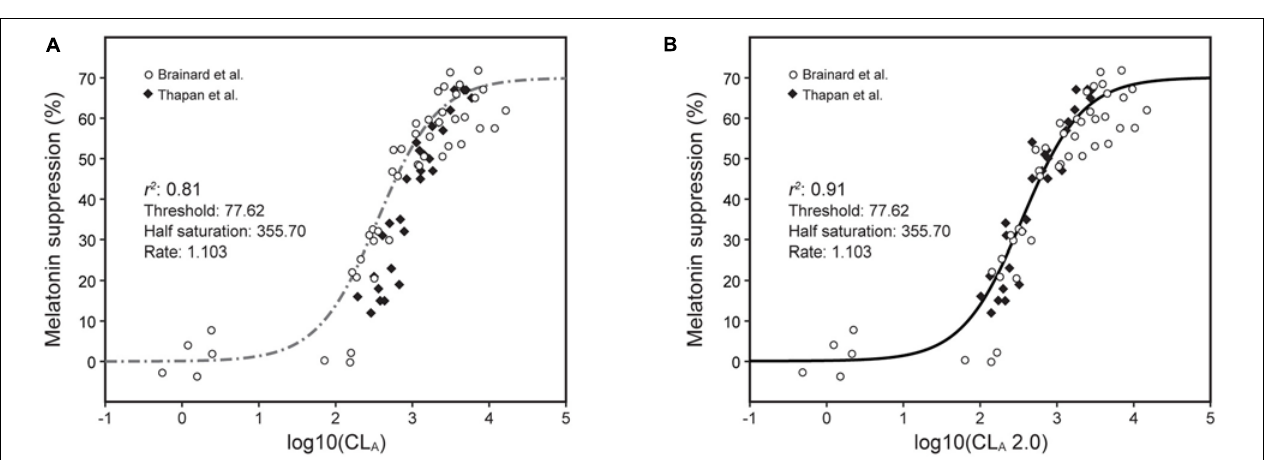
FIGURE 5 | The data in panels (A,B) are for 1-h exposures, plotted as a function of CL A 2.0 from Eq. 3. (A) shows the data separated in terms of three different spatial distributions of the light stimulus: f = 2.0 (green), f = 1.0 (red), and f = 0.5 (blue). (B) shows these same data now adjusted for spatial distribution with the solid line reflecting the CS t , f formulation of Eq. 5. The legend entries in (B) correspond to the light source designations in Supplementary Table 1 and Supplementary Figure 1 ; blue symbols are associated with light sources where b-y > 0 and yellow symbols for light sources where b-y ≤ 0.